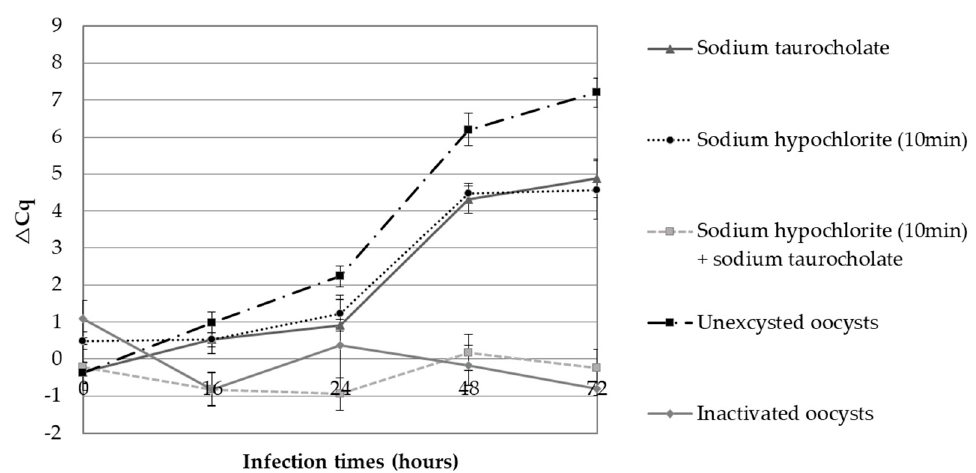
Figure 1. Parasitic proliferation kinetics established from ∆ Cq values. Kinetics of the human ileocecal adenocarcinoma cell line (HCT-8) cells infection by excysted oocysts or not. Oocysts excysted with 1.5% sodium taurocholate (grey triangle), with 2.63% sodium hypochlorite (black round), or with the combination of both (gray square). Unexcysted oocysts (black square) and inactivated oocysts (gray diamond). The parasitic proliferation was assessed after DNA purification and quantification of Cryptosporidium DNA by qPCR. A positive ∆ Cq ( ∆ Cq = Cq w/out cells − Cq with cells ) indicates that the parasites have multiplied within cells. Table 1. Cell culture and quantitative PCR (CC–qPCR) assay results for purified C. parvum oocysts. Number of